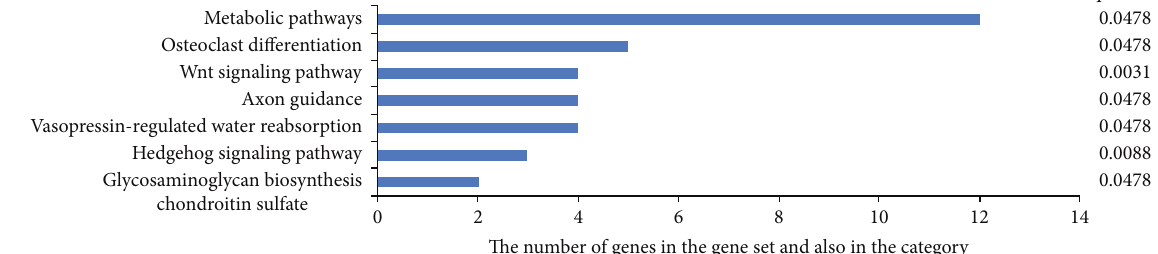
Figure 5: Common pathway analysis of miR-494, miR-139-3p, and miR-6069 according to KEGG function annotations.